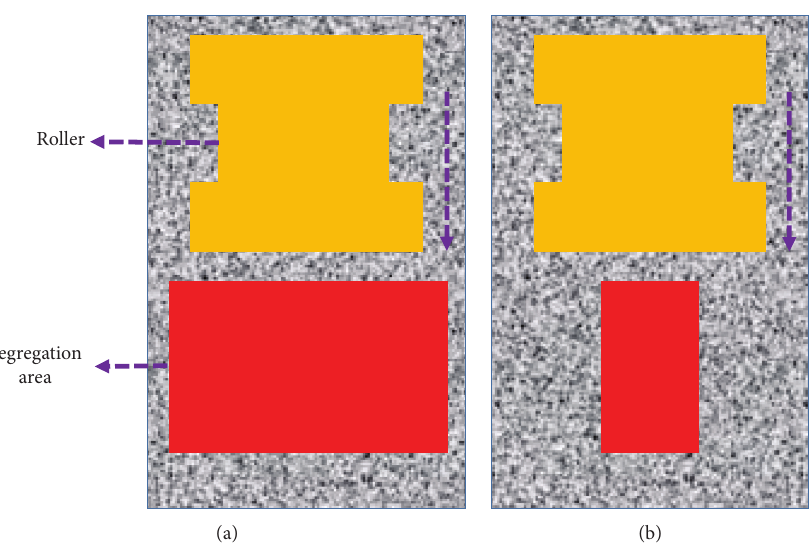
Figure 4: Schematic diagram of the segregation area: (a) large-area segregation; (b) small-area segregation.